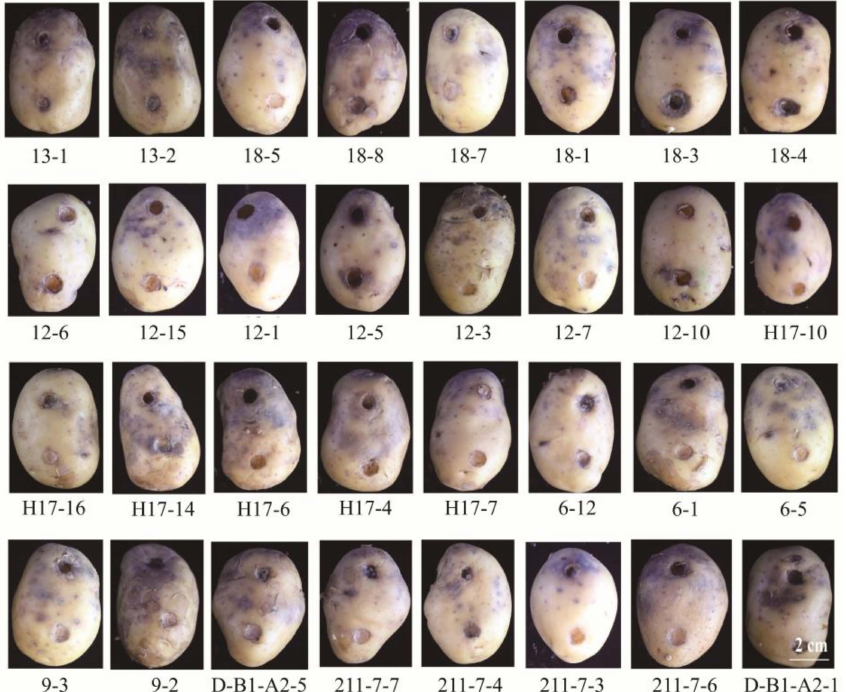
Figure 1. The growth of endophytic candidate isolates and Phytophthora infestans T30-4 on the potato tubers. P. infestans T30-4 was inoculated in the upper hole of the potato, and the endophytic candidate isolate was inoculated in the lower